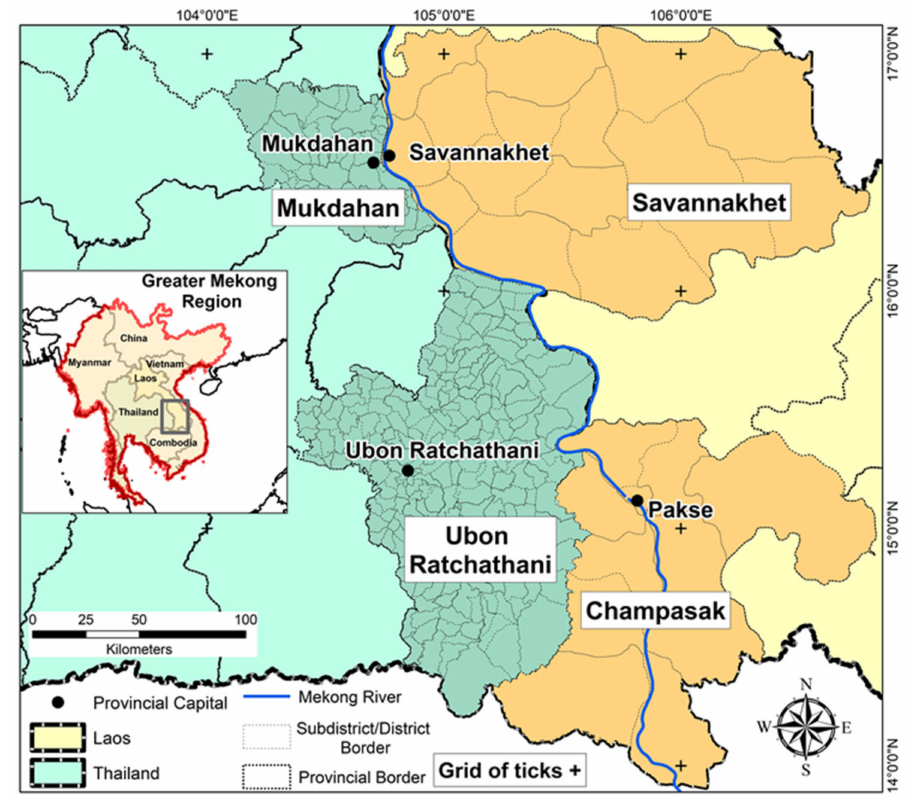
Figure 1. Study provinces in Central and Southern Laos and in Northeastern Thailand (+ grid